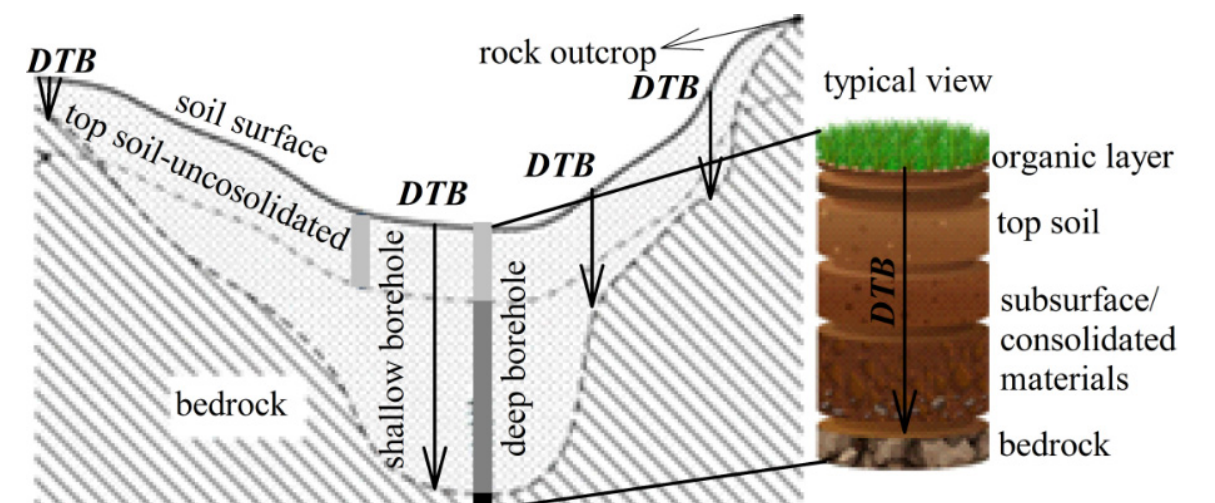
Figure 2. Applied terminology in DTB definition.